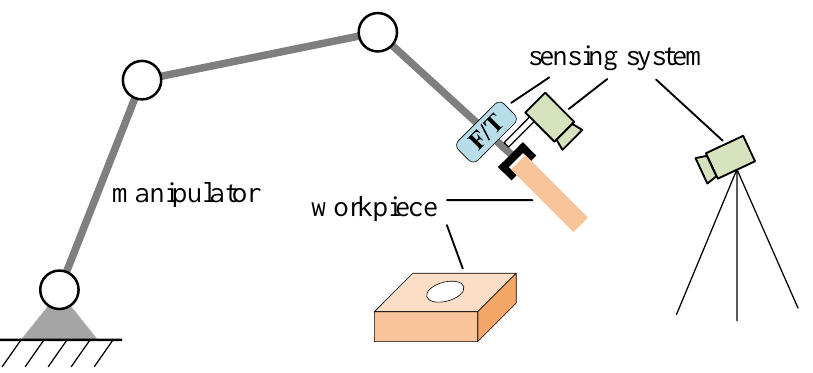
Figure 1. Peg-in-hole assembly system.